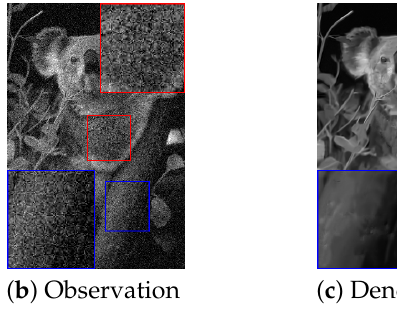
Figure 1. Texture is lost via image